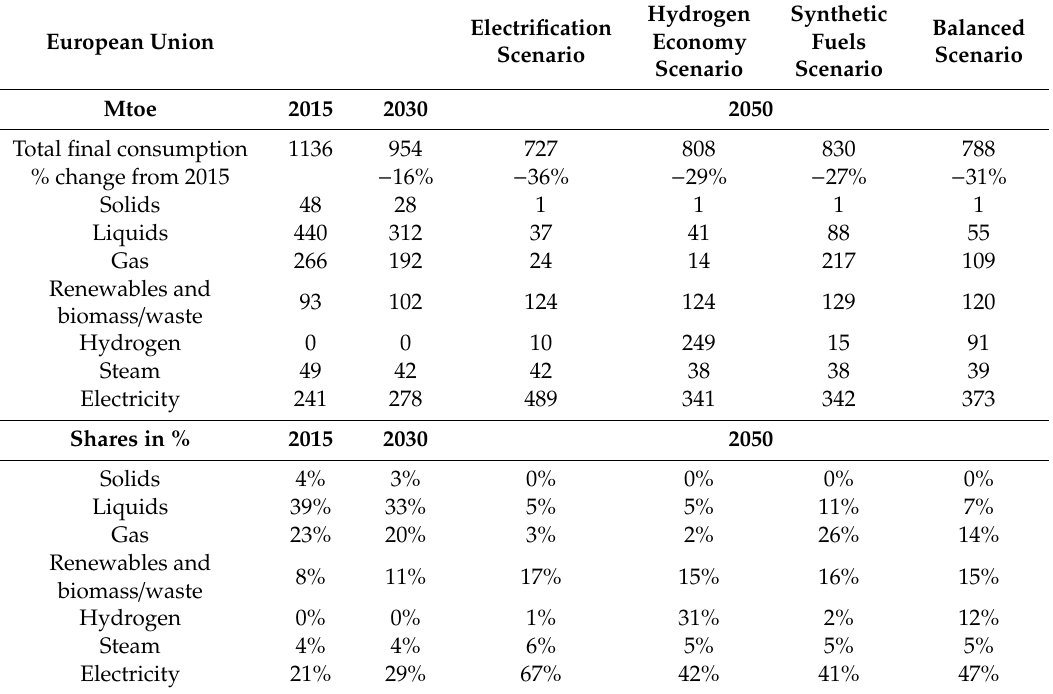
Table 5. Final Energy Consumption in Mtoe.